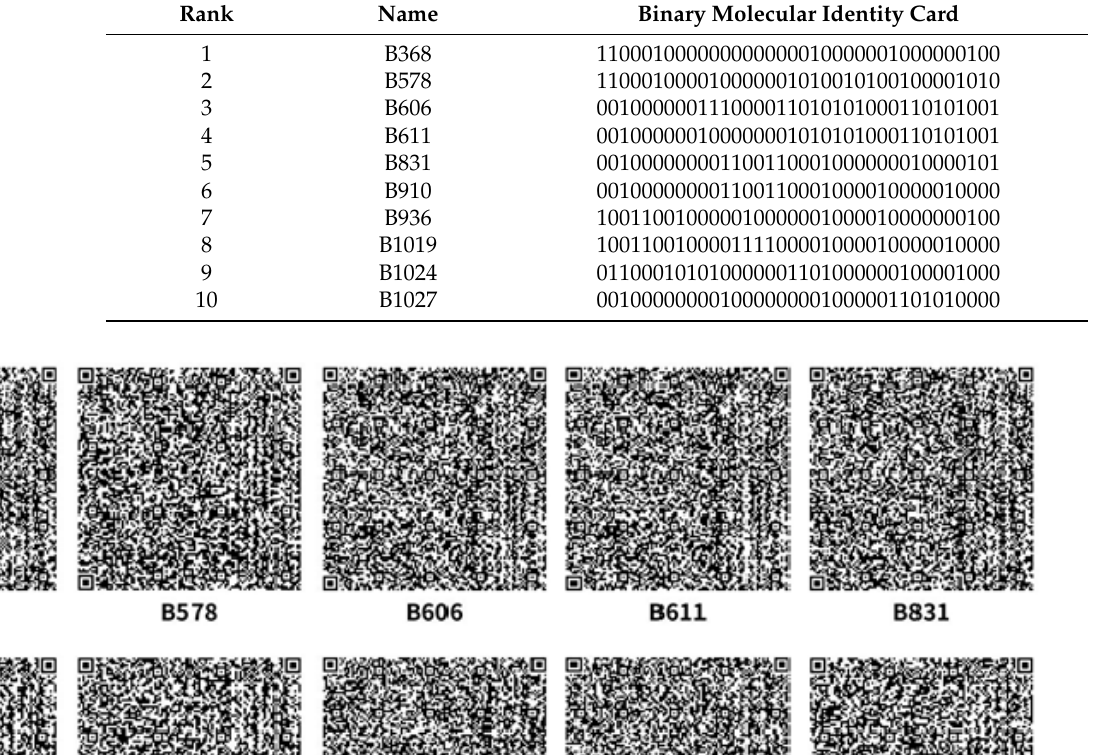
Table 4. DNA fingerprinting of 10 broccoli resources by SSR markers.